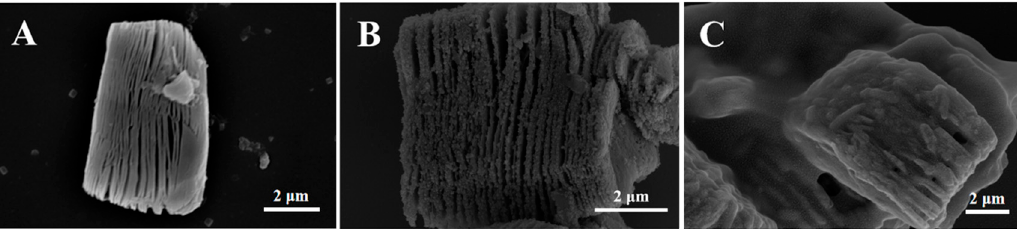
Figure 1. SEM images of ( A ) MXene, ( B ) TiO 2 -MXene and ( C ) TiO 2 -MXene/PEDOT:PSS.